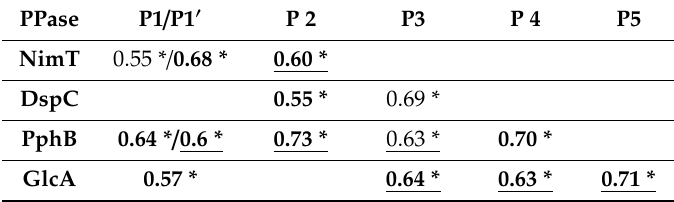
Table 2. PockDrug predicted pockets in the AfPPases. Values are druggability scores generated by PockDrug-Server [17]. In bold, the pockets that match ligand clusters from VSpipe blind docking. Pockets used in the targeted docking are marked with “*”. Underlined are pockets involved in protein–protein interactions. P1 is the active site and P1 (cid:48) is a secondary pocket connected to the active site